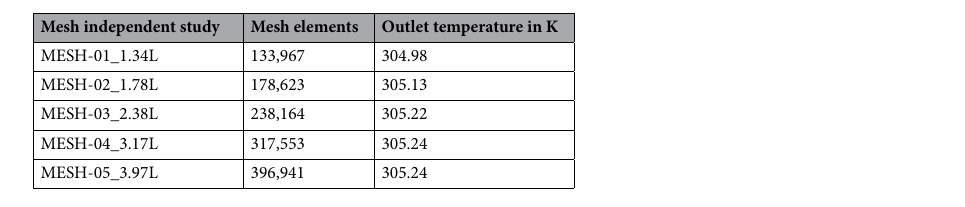
Table 1. The mesh independent